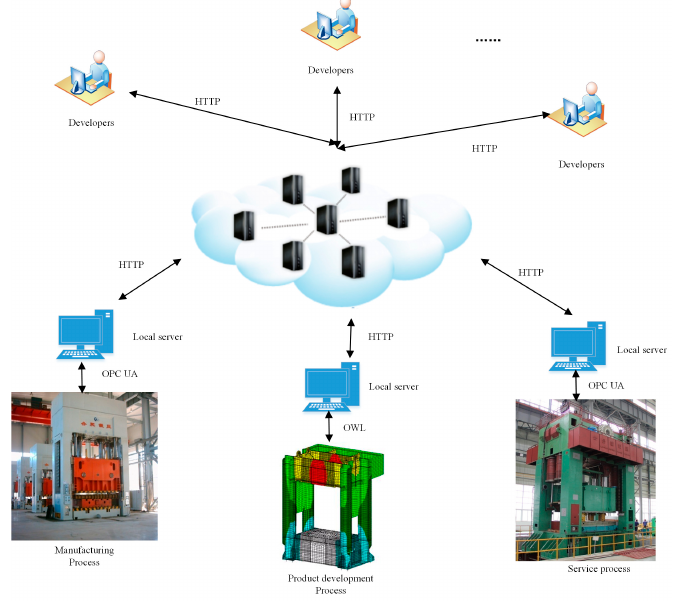
Table 1. The detailed description of design variables.